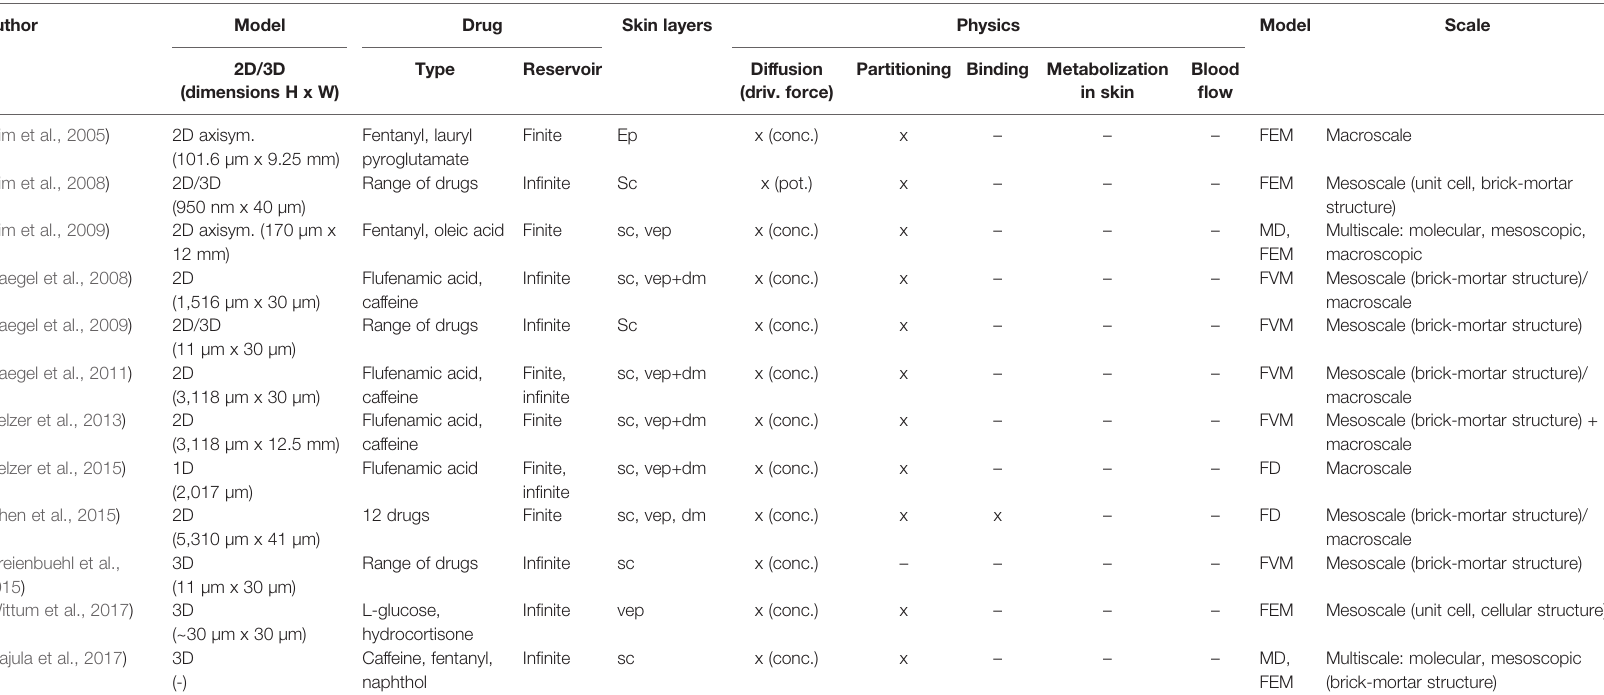
TABLE 1 | Non-exhaustive overview of mechanistic modeling work of transdermal drug delivery over the past decade (ordered